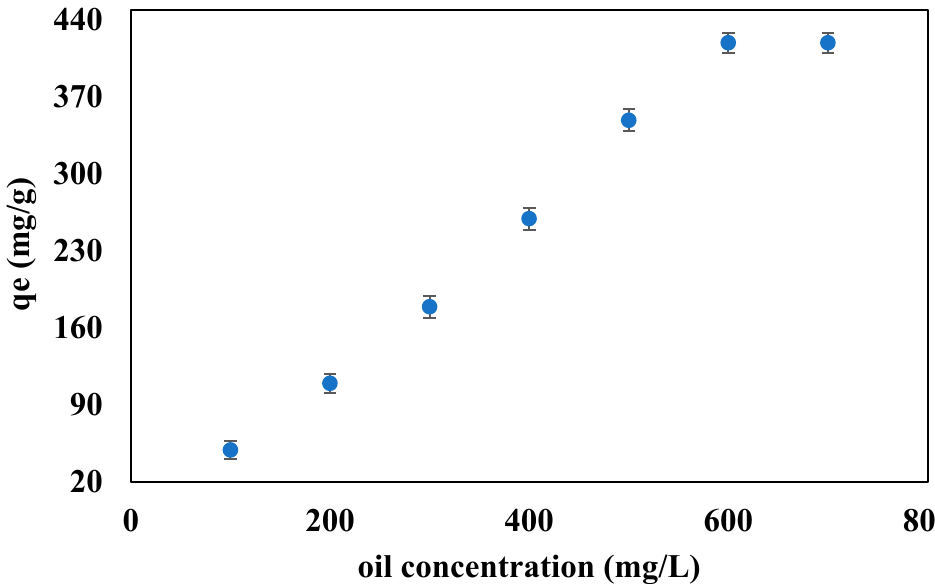
Figure 5. Effect of the initial oil concentration on the adsorption capacity of the beads at 60 min contact time, pH 10, and 10 mg of beads.